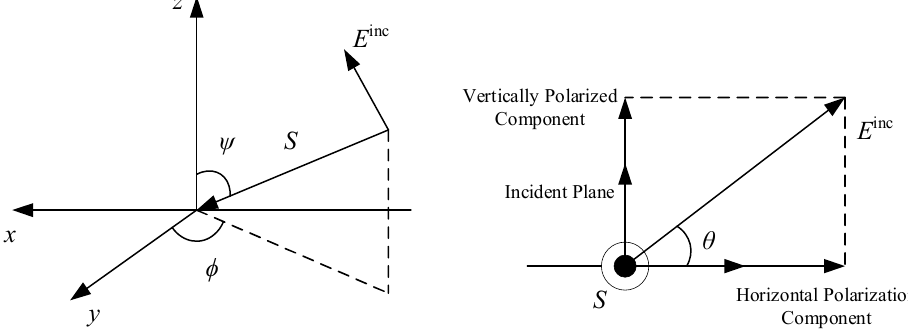
Figure 7. Schematic diagram of electromagnetic wave propagation direction.